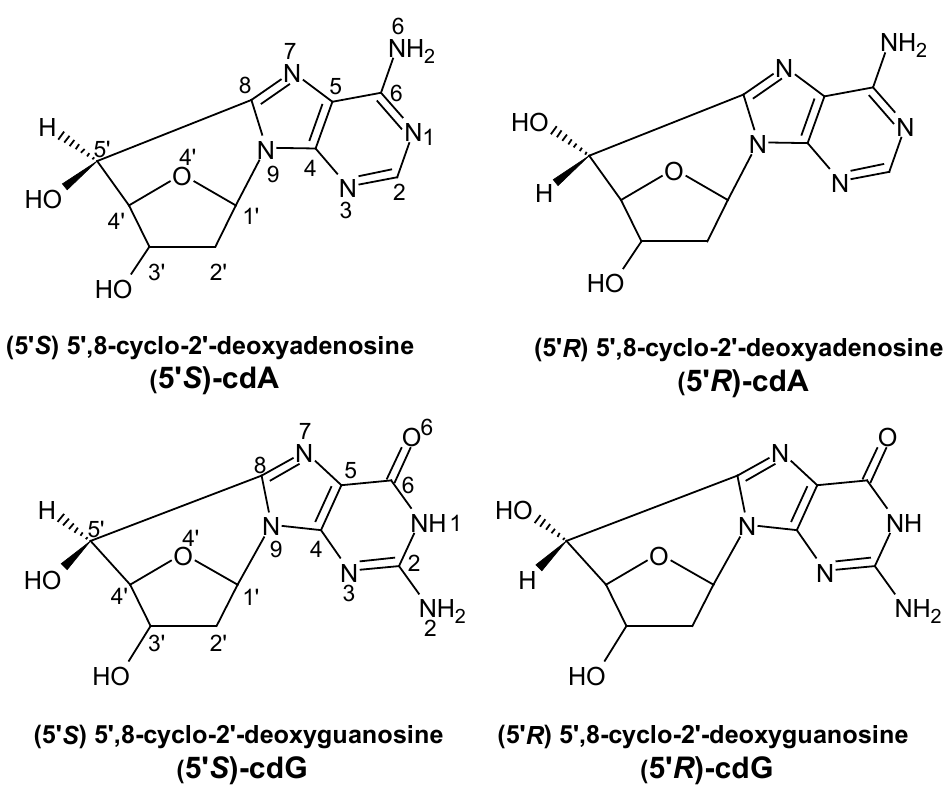
Figure 1. Graphic representation of 5’,8-cyclopurine-2’-deoxynucleoside